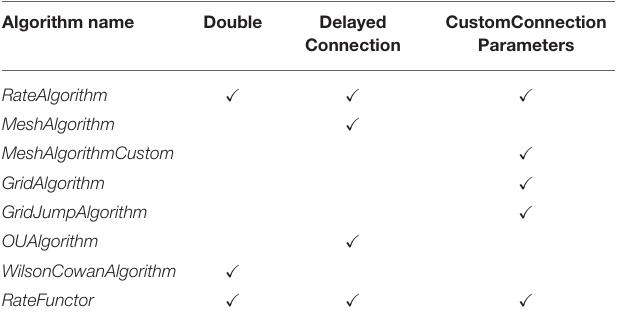
TABLE 4 | Compatible weight types for each algorithm type defined in the simulation XML